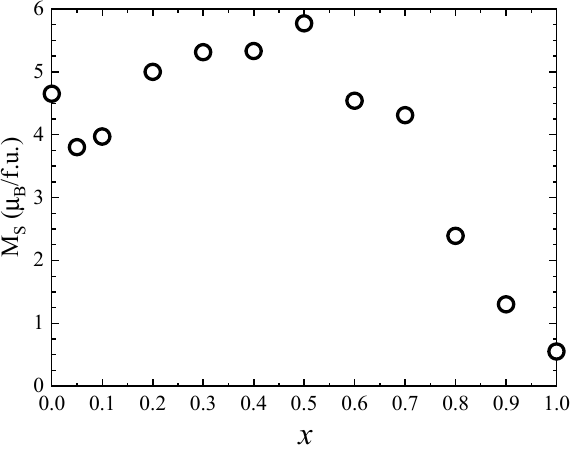
Figure 8. Saturation magnetization of Co 1 − x Zn x Fe 2 O 4 nanoparticles. The magnetic properties of Co 1 − x Zn x Fe 2 O 4 nanoparticles at room temperature were also investigated by recording the hysteresis loops between − 4 T and 4 T (Figure 9). The coercive field has a maximum value of 0.05 T for x = 0.1 and decreases with the Zn content for x > 0.1. The magnetization values at 300 K in 4 T (Figure 10) show a similar behavior to that of the spontaneous magnetization at 4 K.